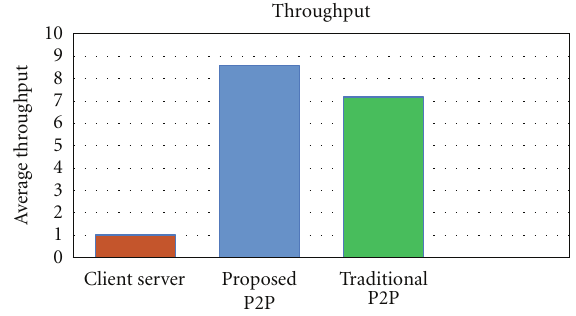
Figure 9: Throughput